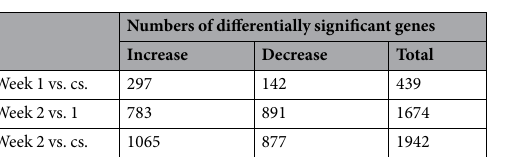
Numbers of differentially significant genes Increase Decrease Total Week 1 vs. cs.